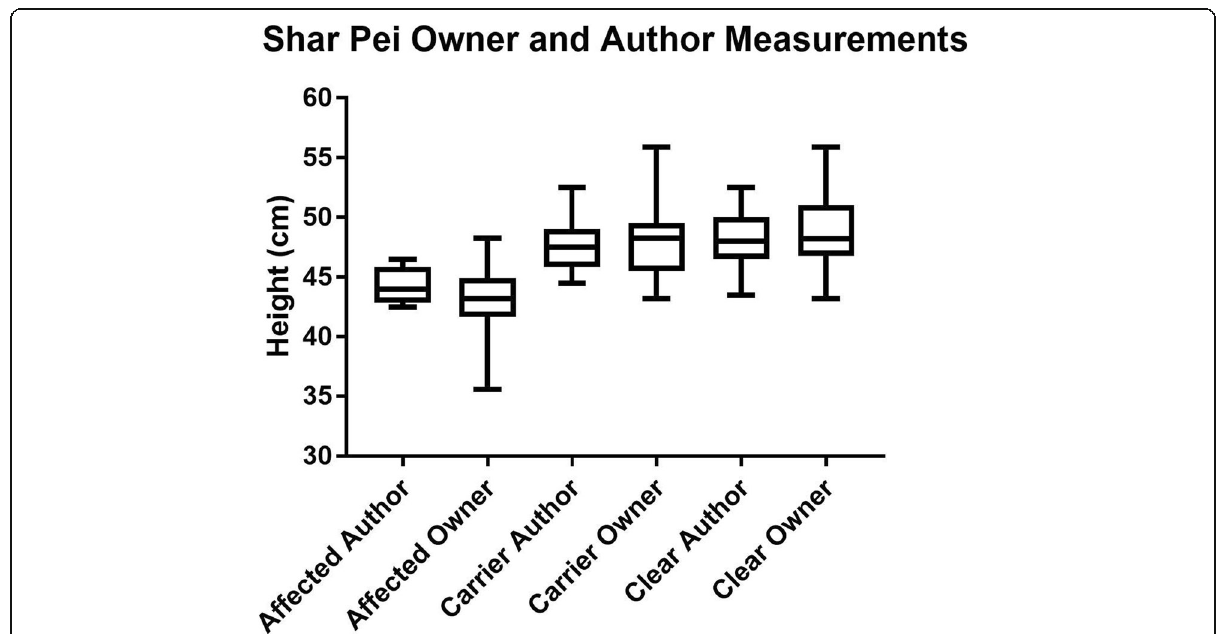
Fig. 2 Box and Whiskers plot to show the height at the withers of affected, carrier and clear SPs, stratified by measurer, demonstrating the upper and lower values, the interquartile range and the median value